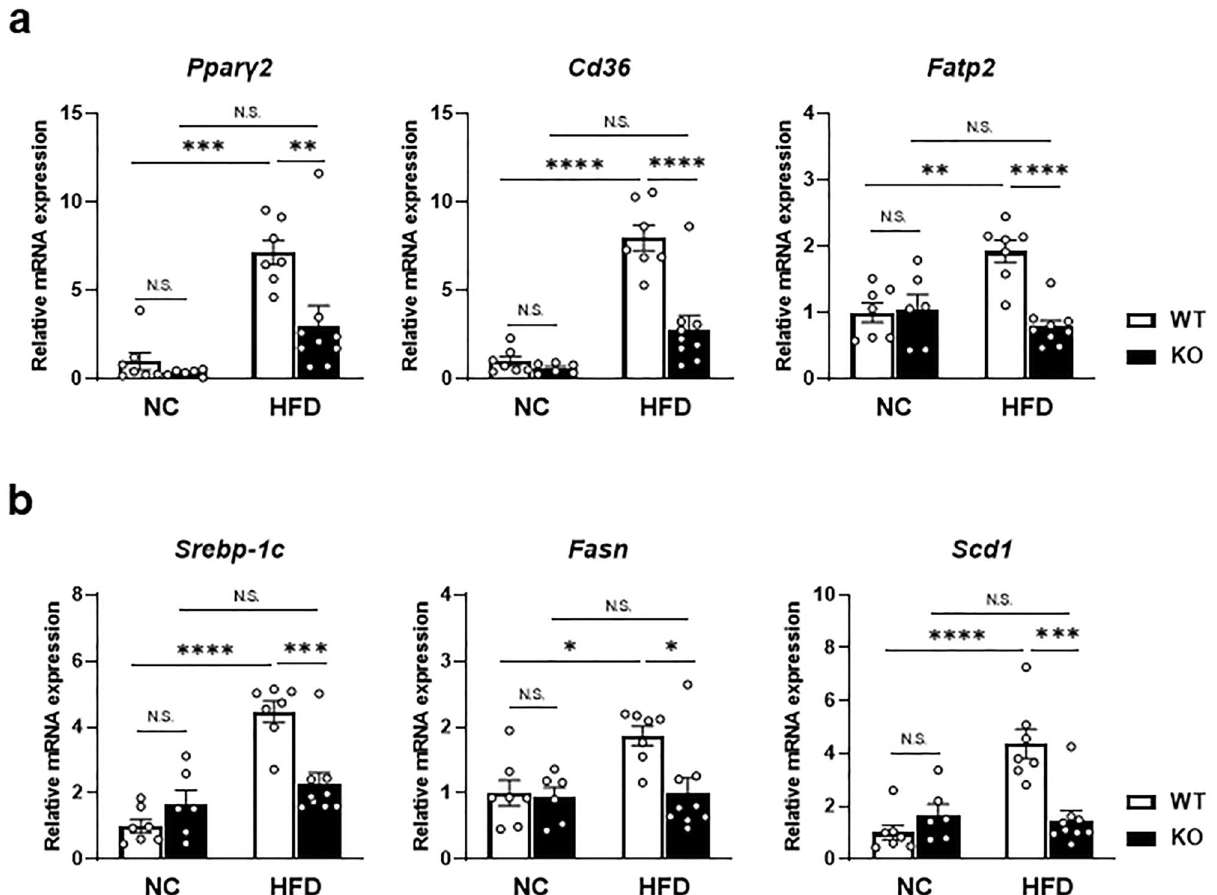
Figure 5. mRNA expression levels of the lipid metabolism-related genes increased by HFD were decreased in FD-KO mice. (a ) Relative mRNA expression levels of the genes related to fatty acid uptake ( Pparγ2 , Cd36 , and Fatp2 ), and ( b) de novo lipogenesis ( Srebp-1c , Fasn , and Scd1 ) in liver of WT mice or FD-KO mice fed with NC or HFD for 17 weeks. N = 7, 6, 7, 9. * p < 0.05, ** p < 0.01, *** p < 0.001, **** p < 0.0001 by one-way ANOVA followed by a Tukey’s post-hoc test.